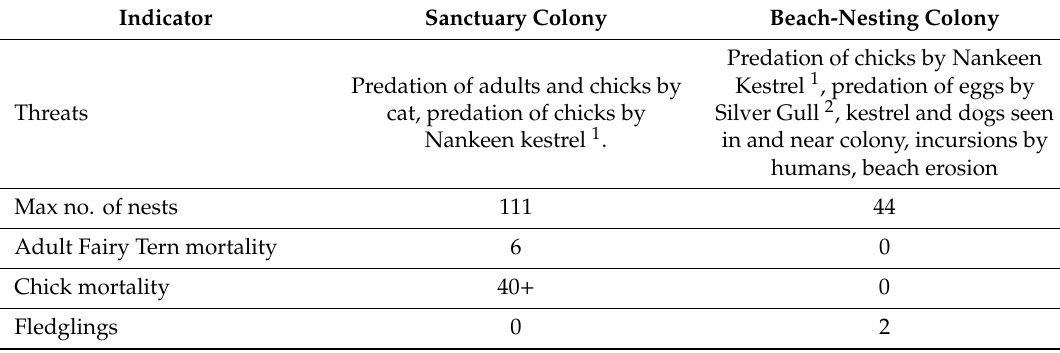
Table 1. Summary of threats, colony development, mortality and fledgling success of nesting Fairy Terns at the sanctuary and beach-nesting colonies in Mandurah during